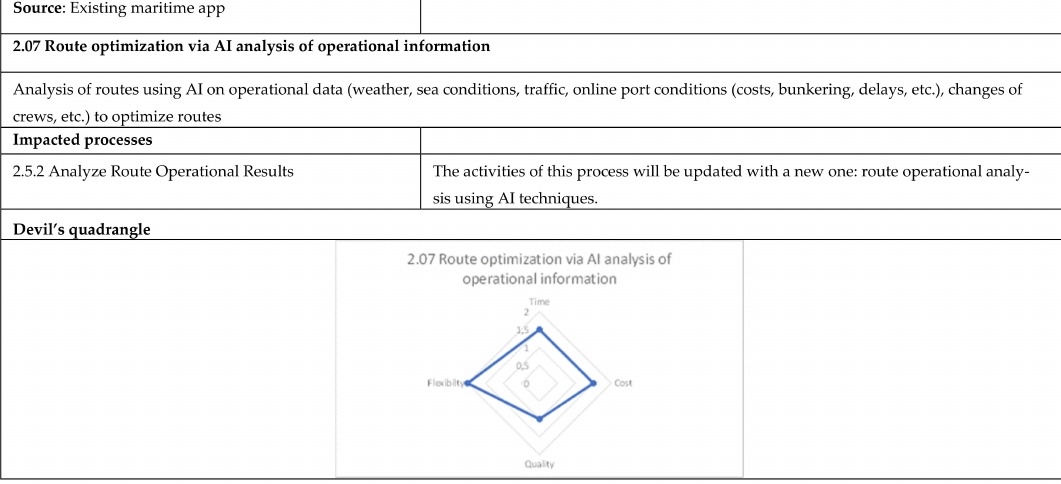
Figure A11. Cont